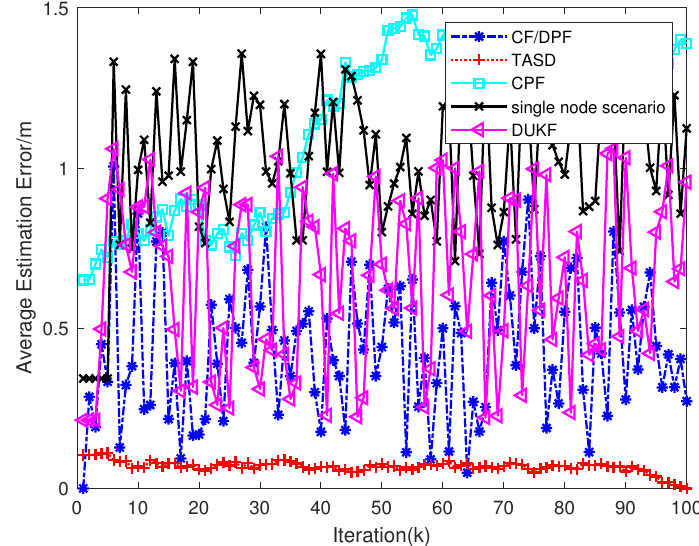
Figure 5. Average estimation errors.